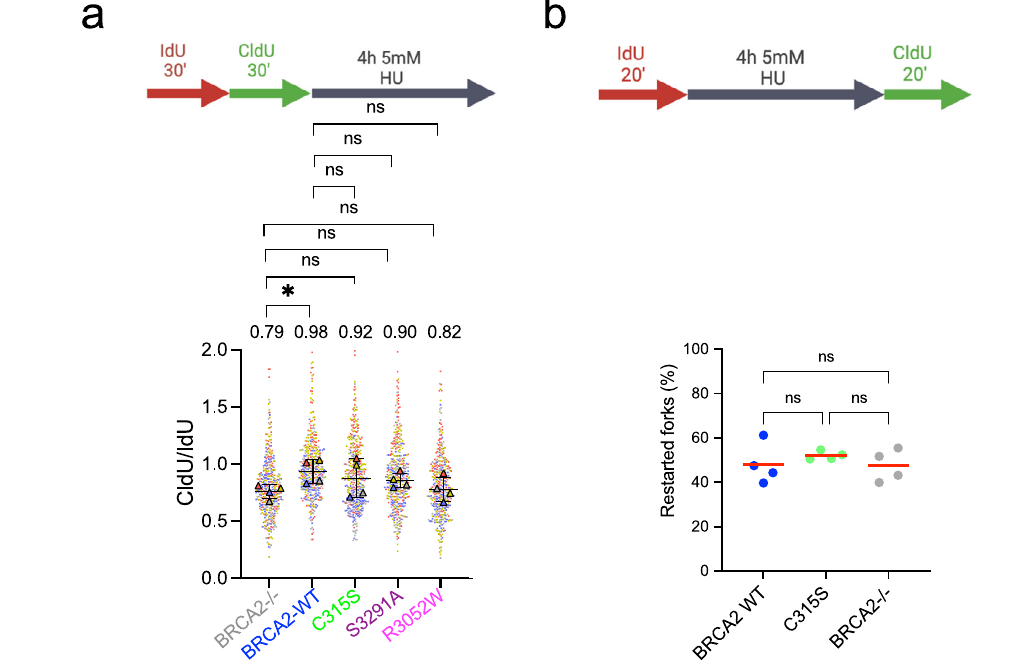
Fig. 4 | Different domains of BRCA2 contribute to replication fork protection. a Labelingschemeofthymidineanalogs(IdUandCldU)followedbyHUtreatment. DLD1-BRCA2-de fi cientcellscomplementedwiththeBRCA2WTandmutatedforms of BRCA2 were labeled with IdU (30min) and then with CldU (30min) followed by 4htreatmentwith5mMHU,asindicated,afterwhichcellswereprocessedforDNA fi ber analysis. Quanti fi cation of the track length ratio of CldU vs. IdU. Individual experiments are represented as a scatter plot with a different color from 100 replication tracks per data set. The super plot representation superimposes the summarystatisticsfromthefourindependentexperimentsontopofthedatafrom all cells. Differences between experiments were calculated using one-way ANOVA